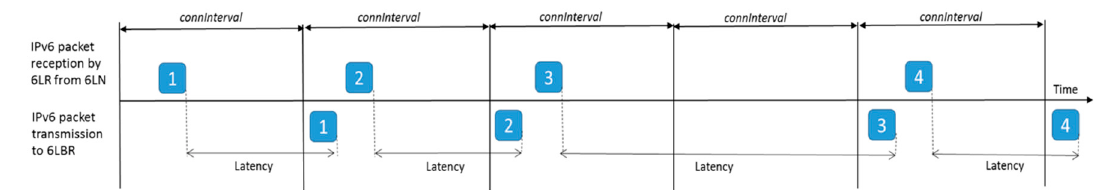
Figure 7. Time diagram for an example that illustrates one-hop IPv6 packet latency when the sender (the 6LR in our testbed) only relays the packets received from the 6LN to the 6LBR. In the example, four packets are transmitted (the packets are identified by numbers 1, 2, 3 and 4).